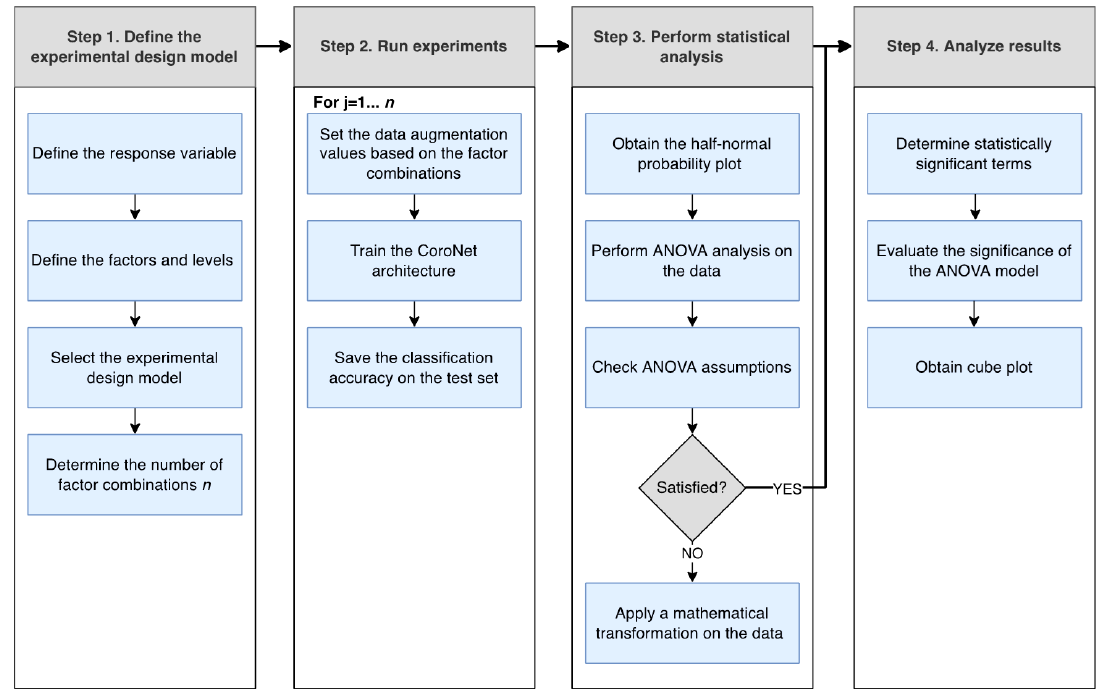
Figure 4. Flowchart of the research